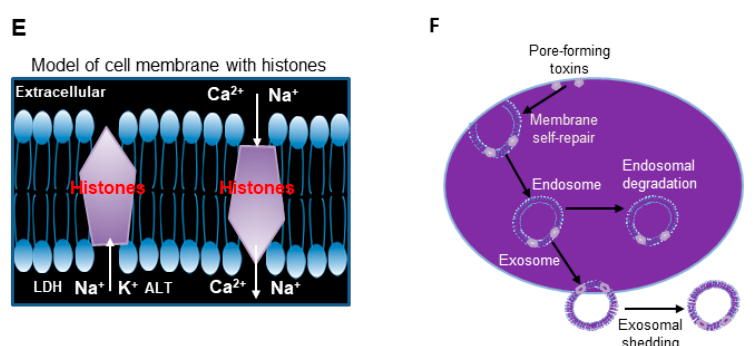
Figure 5. Extracellular histones interact with phospholipids to interrupt membrane integrity. ( A ) and ( B ). Comparison of phosphate groups (red) on double-stranded DNA (A) and cell membrane (B). Both double-stranded DNA and cell membrane have bilayers of phosphate groups. ( C ) Top panel shows the basic structure of phospholipid (phosphatidylcholine as an example) containing a phosphate group (red square). The lower panel shows a DG molecule without a phosphate group. ( D ) Typical binding curves of liposomes (PM) containing PC, PE, and PS, as well as glycolipids (DG) to histone H4 + H3 using Biacore X100. ( E ) A proposed model of interaction of histones with bilayers of lipid membrane to allow ions and proteins to flow across the cell membrane. ( F ) Potential membrane self-repairing mechanisms of the damage induced by pore-forming